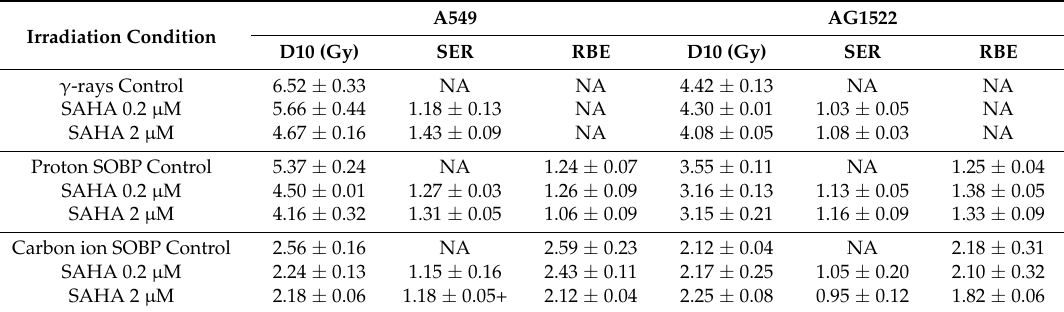
Table 1. SAHA-induced radiosensitization in A549 and AG1522 cells in different qualities of radiation. D 10 , Sensitization Enhancement Ratio (SER), and Relative Biological Effectiveness (RBE) values are mean ± standard error of the means.